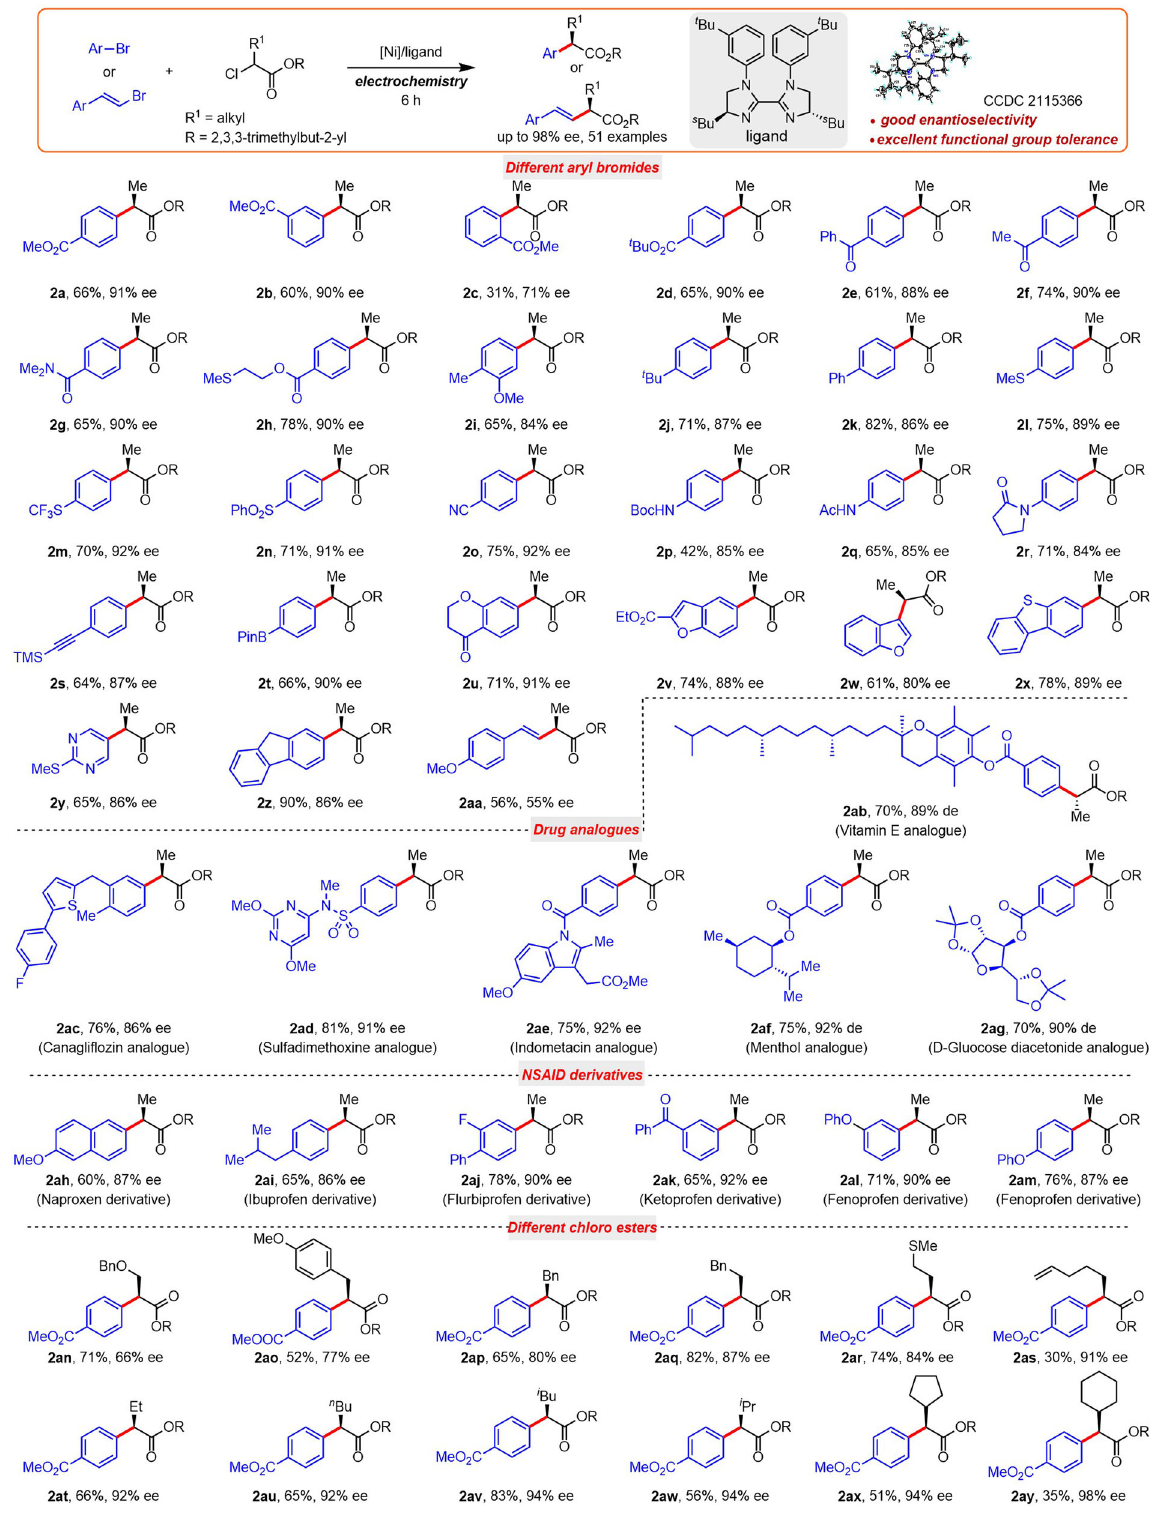
Fig.2|Evaluationofsubstratescope. Yieldofisolatedproductsunlessotherwise indicated. The reaction was carried out in an undivided cell with 1a (0.2mmol), ( rac )- 1b (2.0 equiv), NiBr 2 (cid:129) glyme (10.0mol%), L7 (15.0mol%), DMAc (0.1M), n -Bu 4 NBF 4 (1.0 equiv),TTMSS(3.5 equiv),2,6-lutidine (3.0 equiv),platinum anode